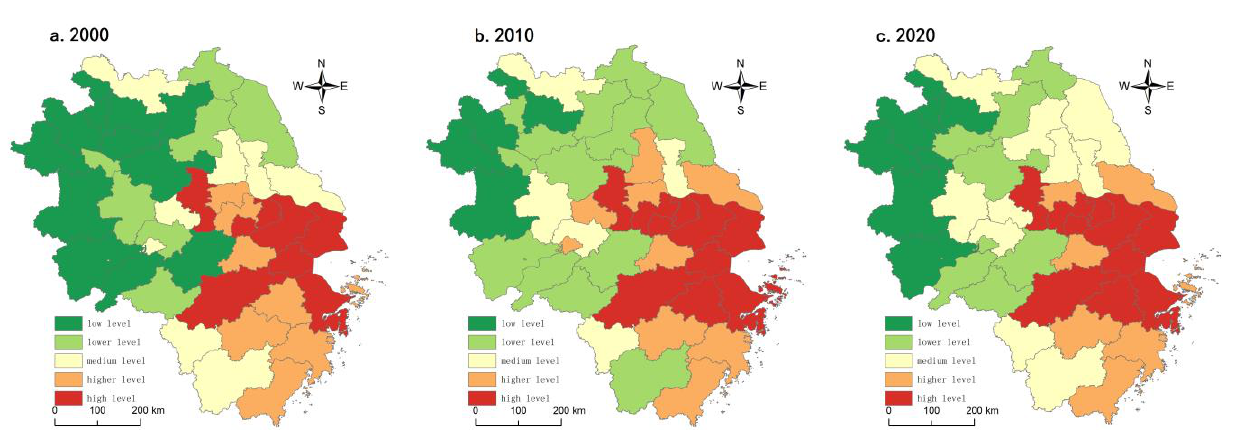
Figure 8. Economic development level of the Yangtze River Delta region, 2000 – 2020.